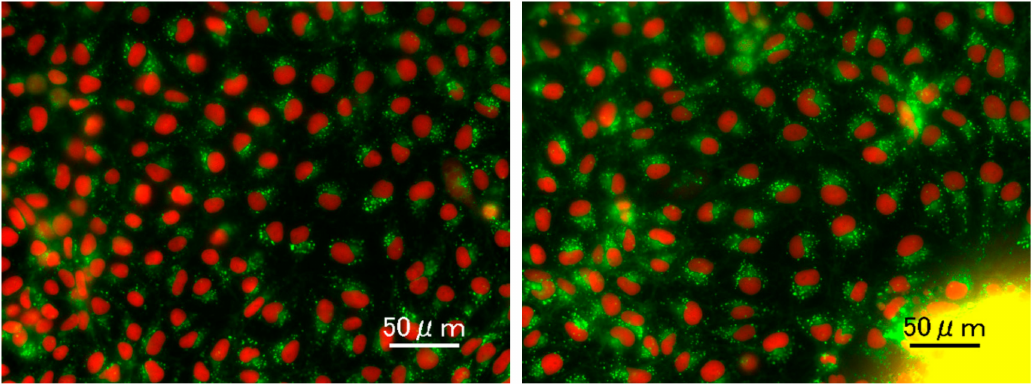
Figure 3. Homogeneity of the di ff erentiation. GAPDH-2A-NLS-TdTomato knock-in KhES-3 line, whose nuclei emit red fluorescent light, was subjected to di ff erentiation in the absence of cytokine cocktail.